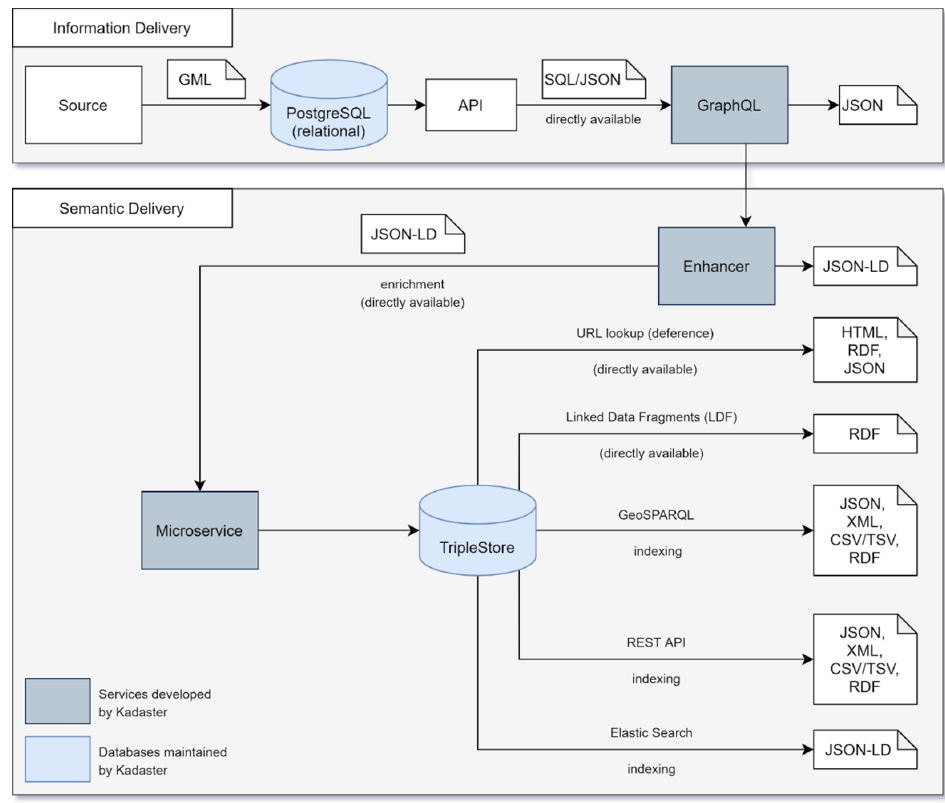
Figure 2. Architecture supporting the ETL process which delivers linked data.